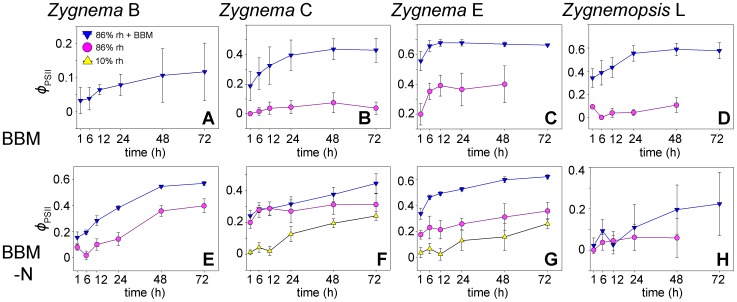
Recovery of effective quantum yield (Φ
PSII) during rehydration after 24 hours desiccation.Each panel compares the performance of the same culture desiccated under different conditions; no plots were constructed for those regimes that were lethal for all of the cells. Samples were collected from cultures pre-cultivated on agar media: A–D: cultures grown on regular agar medium (A BBM); E–H: cultures grown on BBM without nitrate (A BBM-N). Results are means ± standard deviations of four independent experimental replicates.